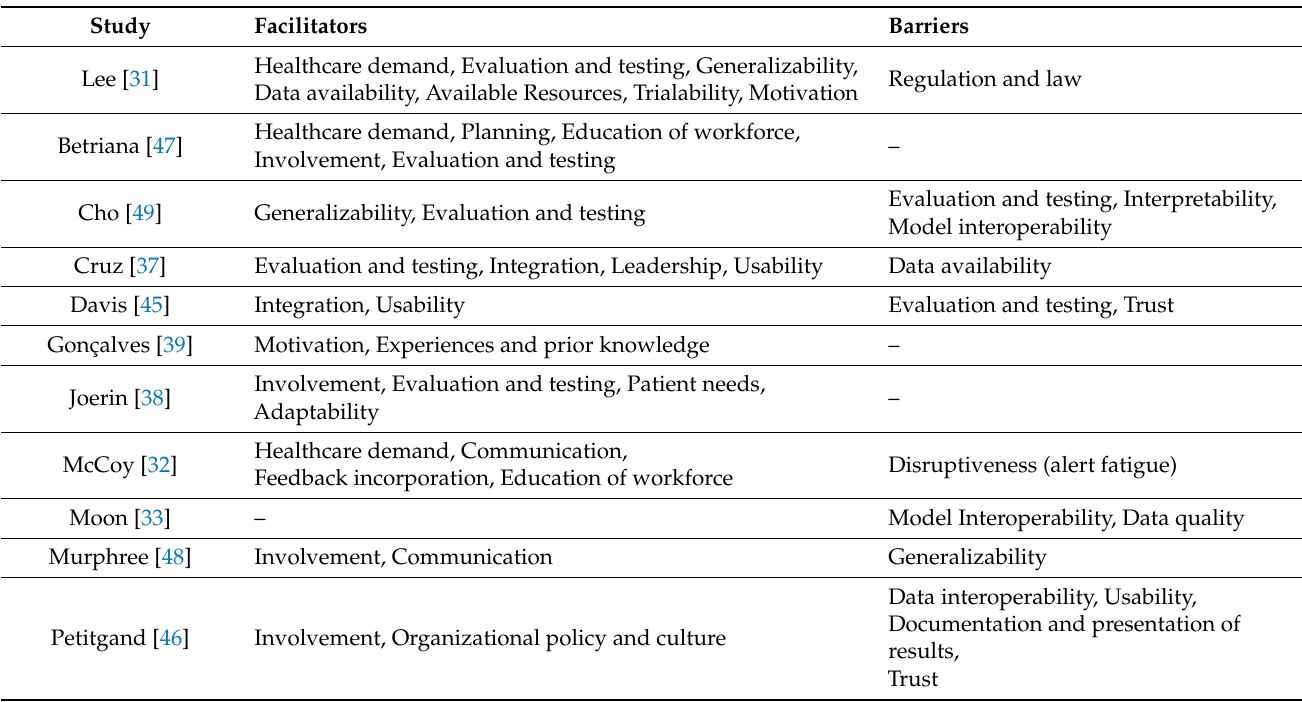
Table 5. Facilitators and barriers based on the